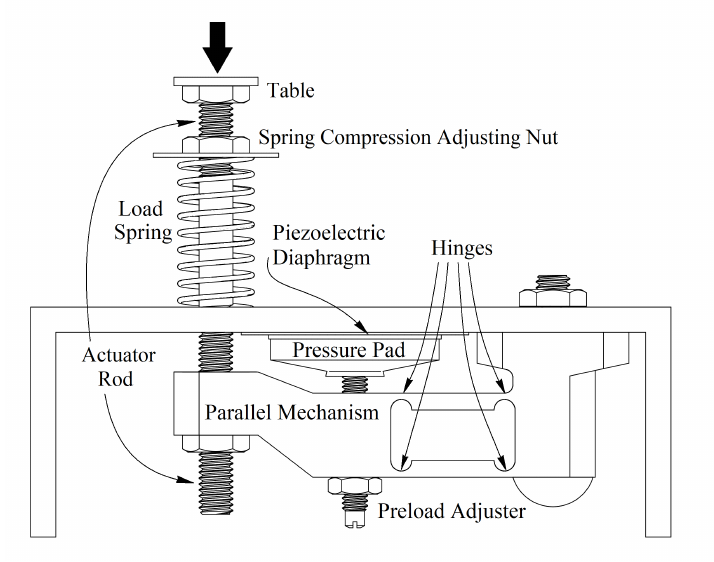
Figure 2. Test equipment for obtaining response